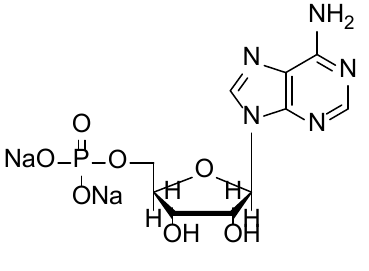
Figure 3 : Structure of AMPNa